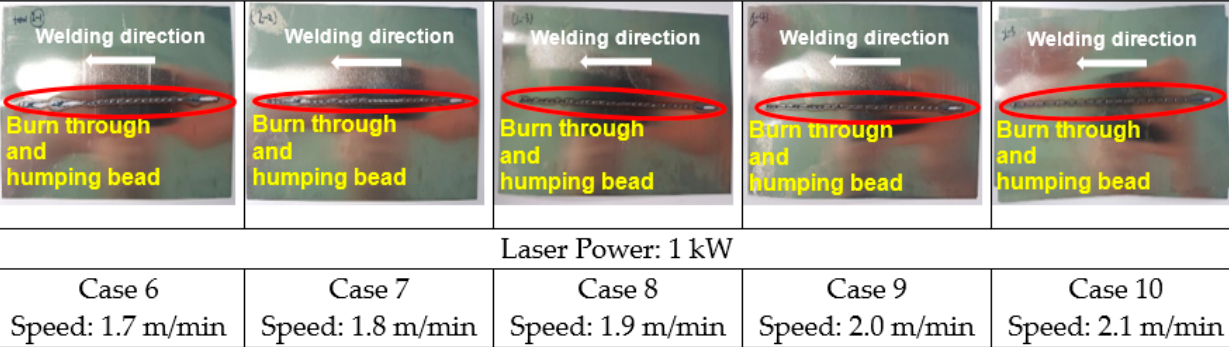
Figure 10. Surface geometry of the second lap joint welding experiment.